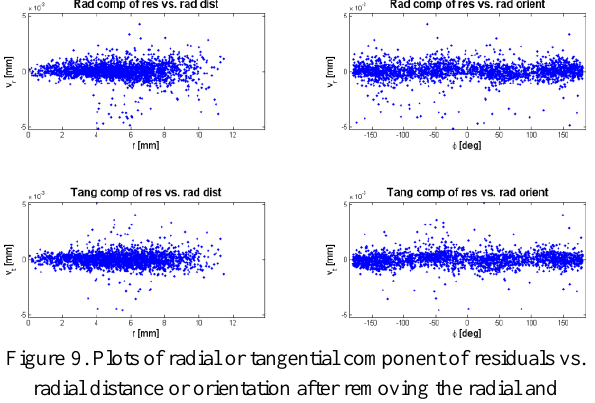
Figure 9. Plots of radial or tangential component of residuals vs. radial distance or orientation after removing the radial and “local” lens distortions for the 24 mm lens calibration of the Canon T3 (1100D)